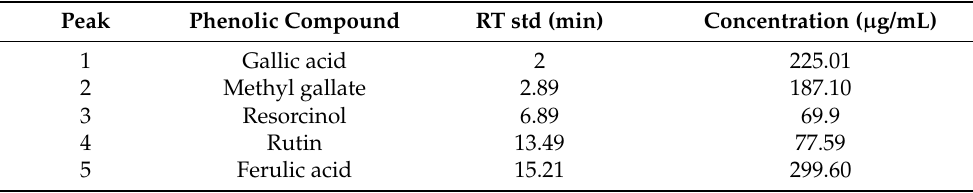
Table 1. Phenolic compounds identified using HPLC in a polyphenol extract of A. europaea.